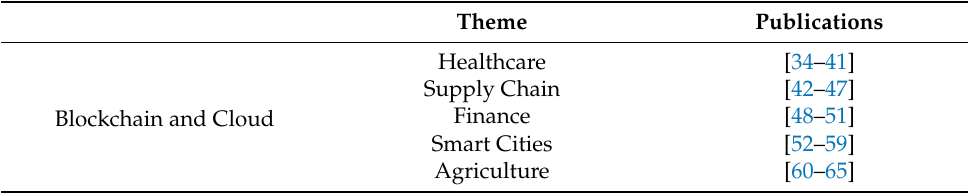
Table 2. Blockchain–Cloud Application